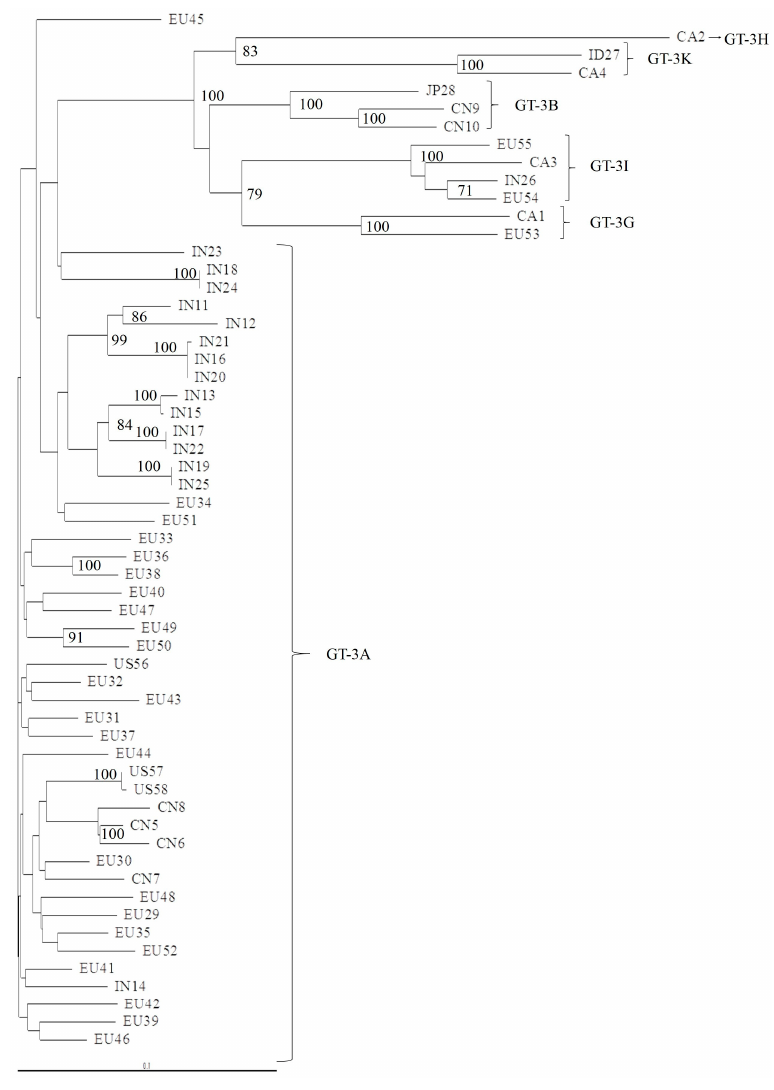
Figure 4. Phylogenetic tree of the NS3 region of 58 complete genomes retrieved from the Los Alamos database. The maximum-likelihood phylogenetic rooted tree of the NS3 protease region shows the relationships between different GT-3 subtypes of 58 isolates that had full genomes available. The geographic origin of each isolate is indicated with a code, followed by a progressive number. The geographic codes are: BR = Brazil, EU = Europe, US = USA, AU = Australia, CA = Canada, PK = Pakistan, IN = India, TH = Thailand, CN = China, ID = Indonesia, and JP = Japan. Evolutionary distances are indicated next to the branches.